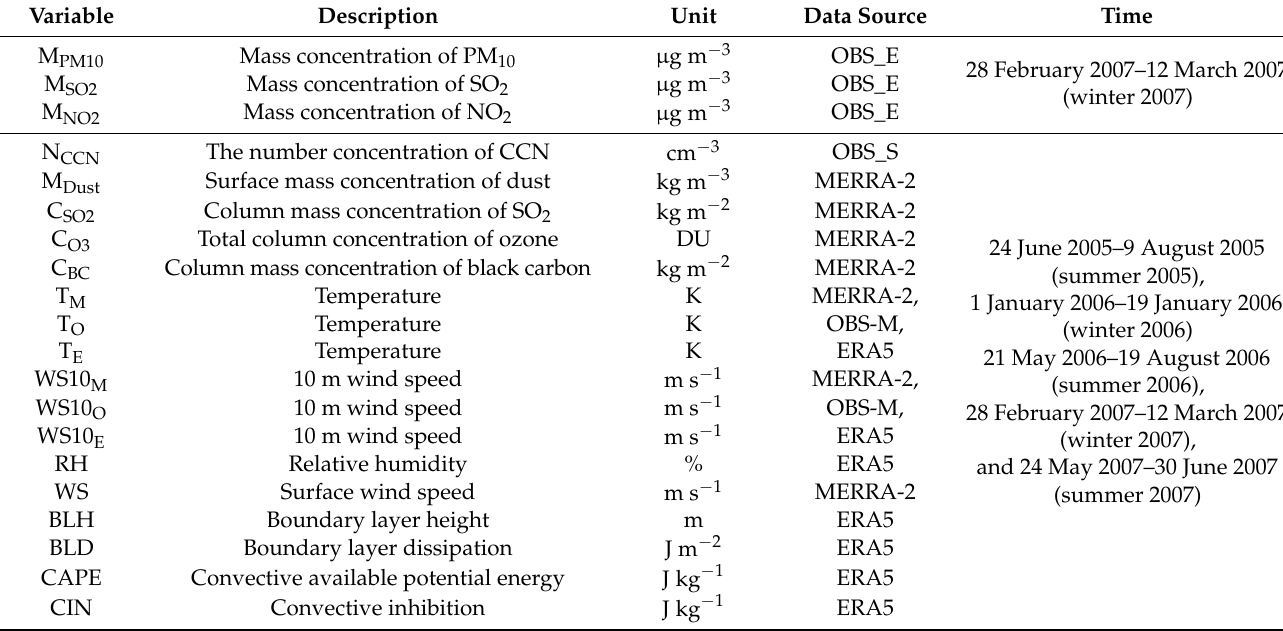
Table 1. The detailed information for variables used in this